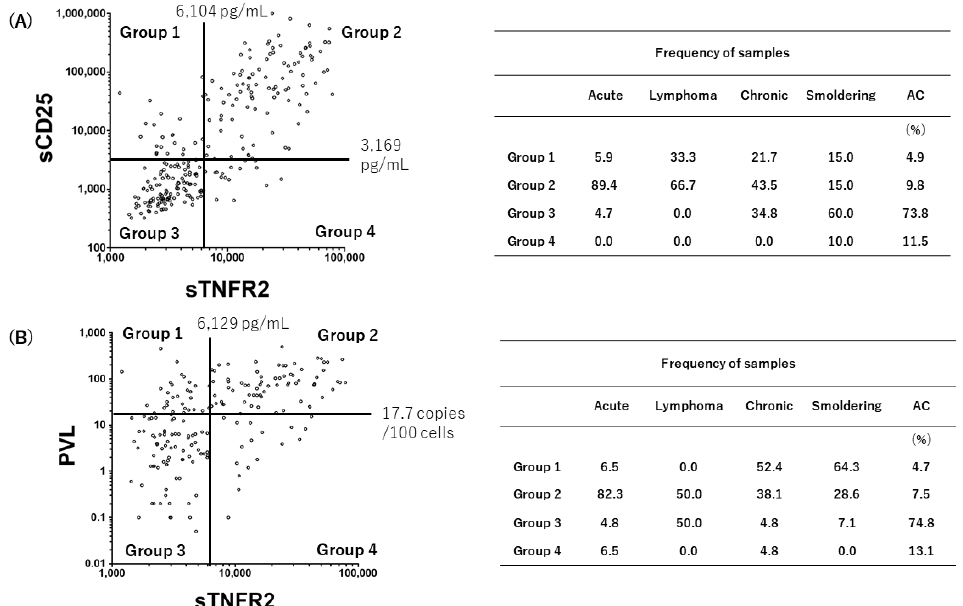
Figure 3. Grouping of ATL patients and ACs into four categories based on the scatter of the putative ATL biomarkers. Grouping data based on the sTNFR2/sCD25 scatter ( A ) and sTNFR2/PVL scatter ( B ) are shown on the left, and category frequencies (percentages) are summarized in the tables on the right. Each cut-off value was determined as described in the Section 2.